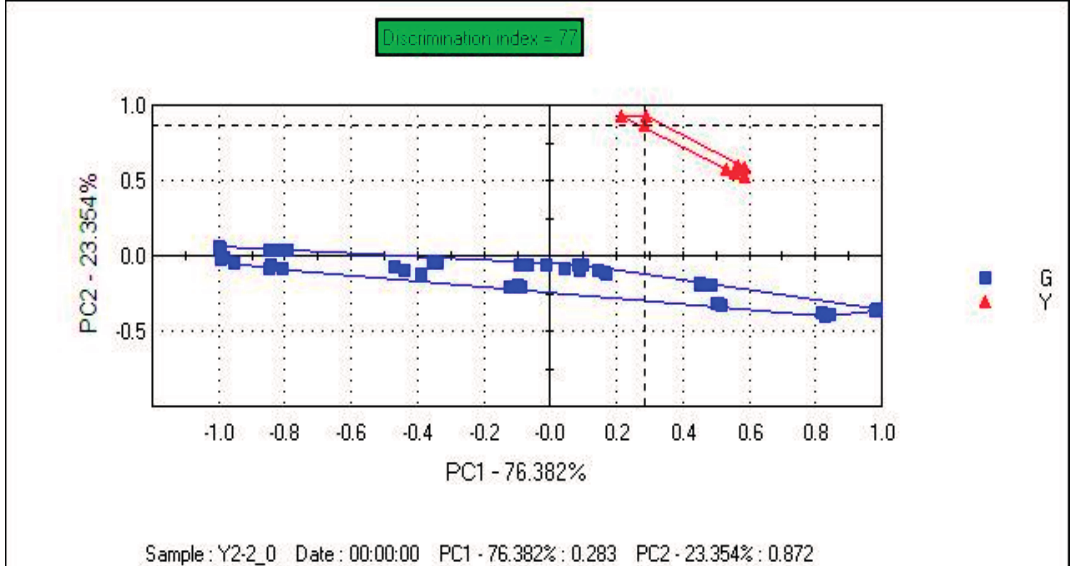
Figure 2. Principal component analysis (PCA) scatter plot for samples (FEM1).